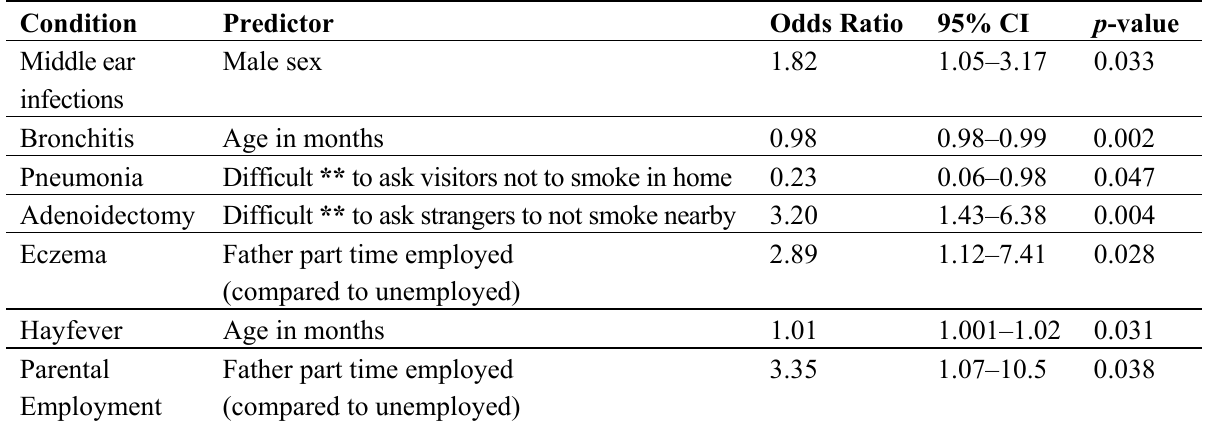
Table 3. Logistic regression predictors of medical conditions among children *